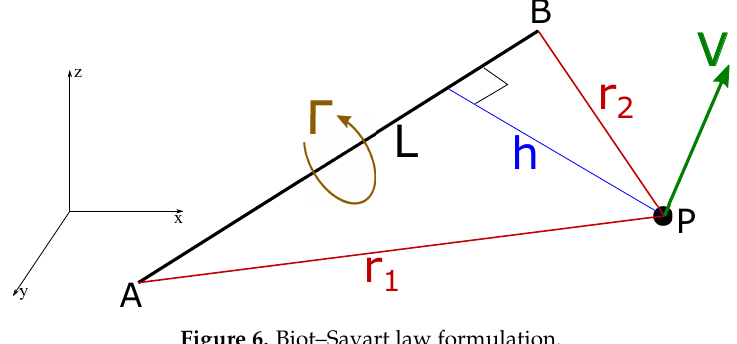
Figure 6. Biot–Savart law formulation.